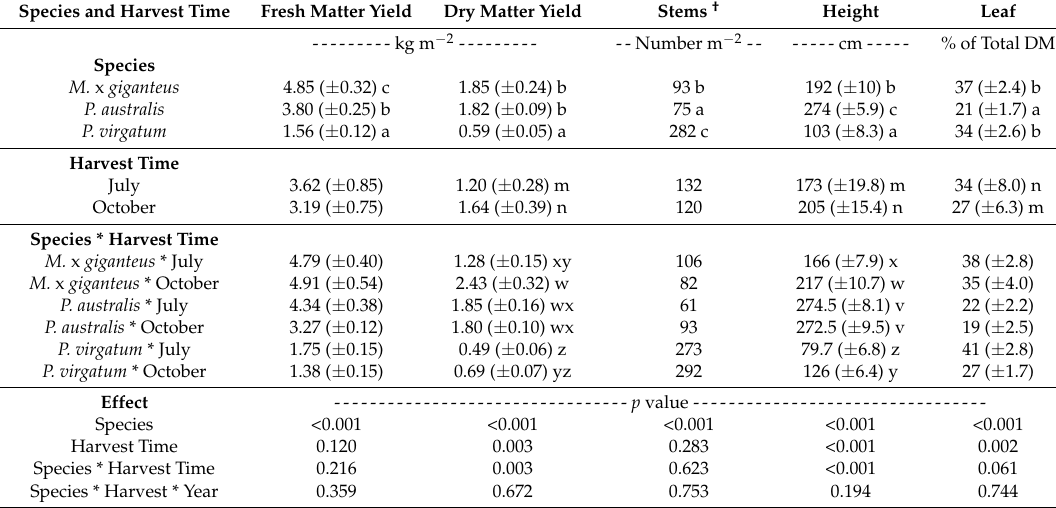
Table 4. Mean ( ± standard error) plant characteristics for Phragmites australis , Panicum virgatum , and Miscanthus x giganteus ‘Nagara’, at three sites in Southwestern Ontario, Canada, harvested over two seasons in 2013 and 2014 ( n = 6). Results of the three-way ANOVA also shown on Table 3. Means followed by the same letter in each column were not significantly different according to Tukey’s range test ( p >